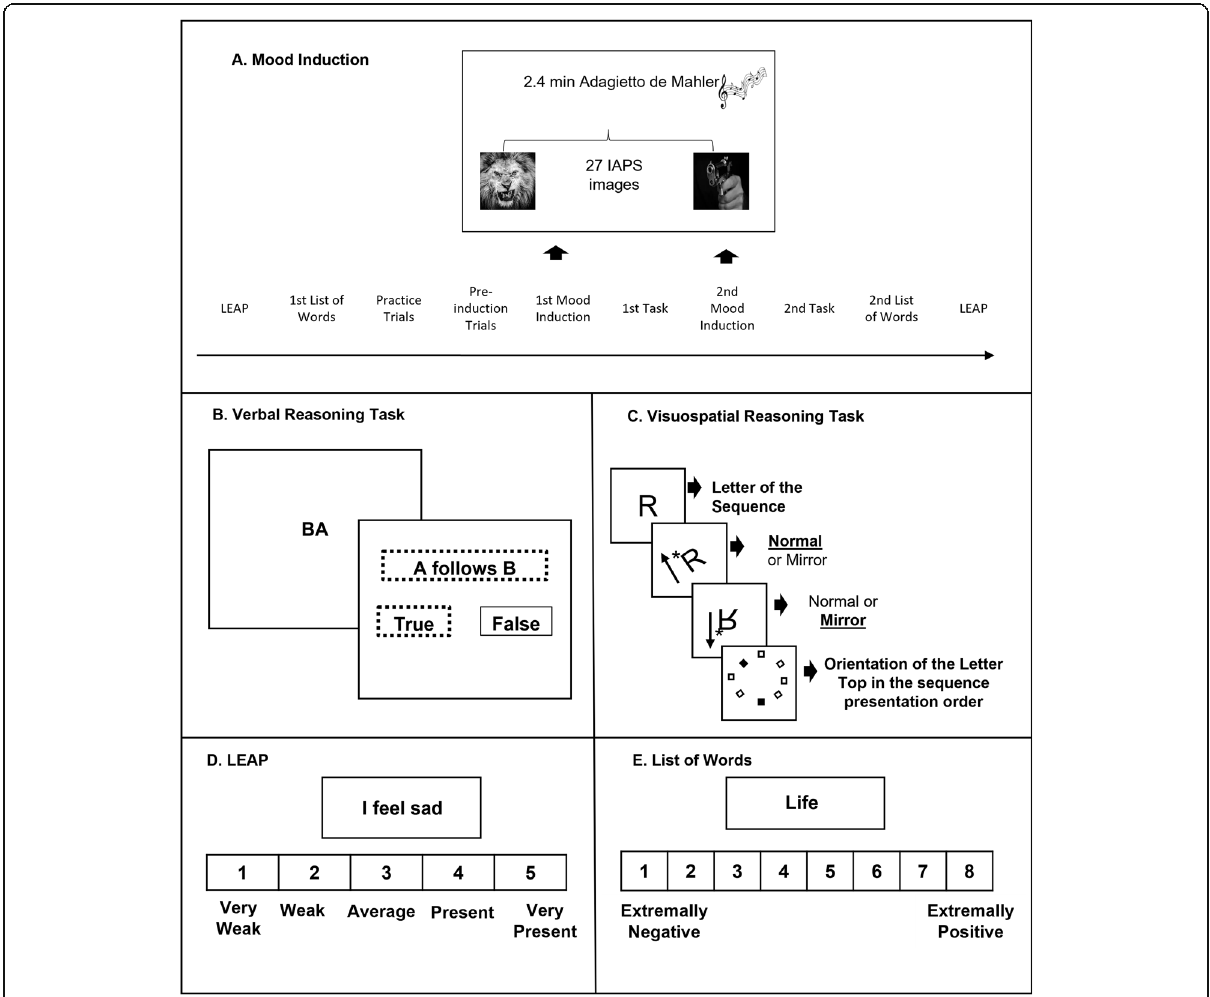
Fig. 1 Sequence of events in a trial. Note: ( A ) Illustration of the sequences of events in the negative group, ( B ) verbal task, ( C ) visuospatial task (e.g., sequence of two letters), ( D ) LEAP, and ( E ) list of